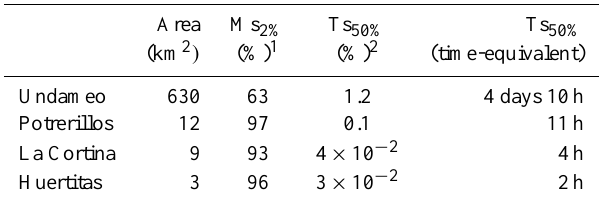
Table 1. Temporal variability of suspended sediment for each